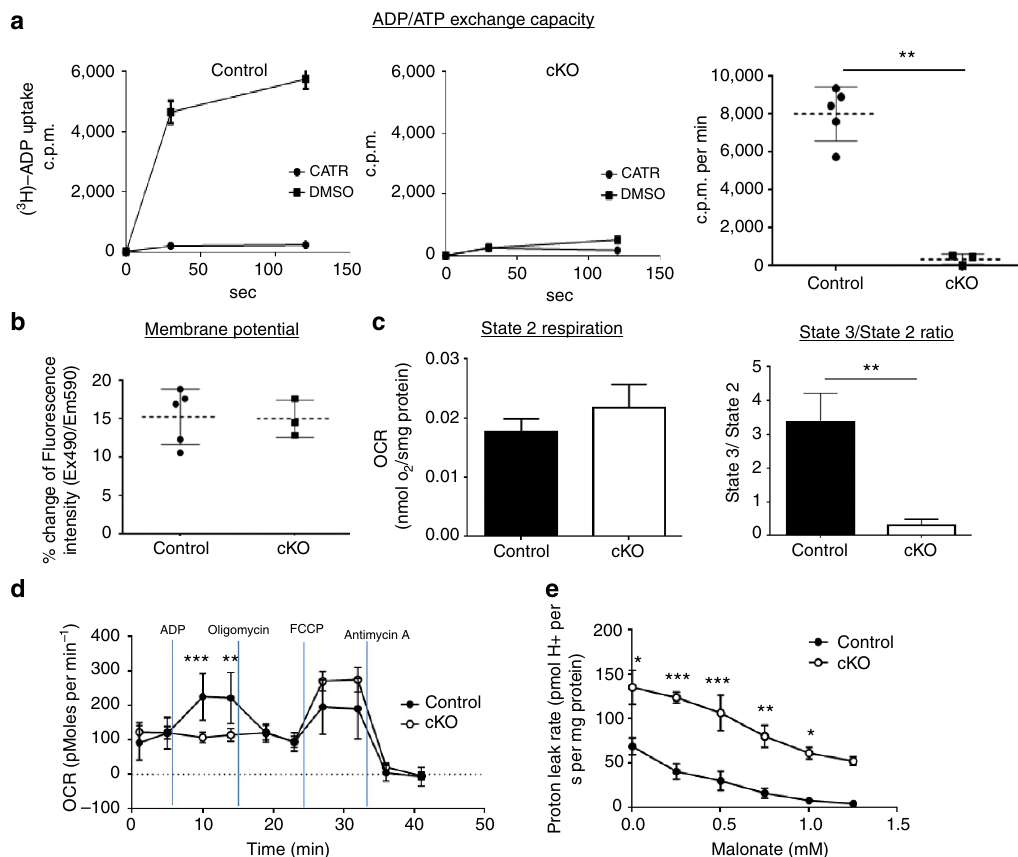
Figure 3 | Characterization of Ant2 -deleted liver mitochondria. ( a ) ADP/ATP exchange capacity measured by [ 3 H]ADP uptake in the presence or absence of the ANTspecific inhibitor, carboxyatractyloside (CATR). Left two panels show representative data from control and Ant2 cKO liver mitochondria, while the far right graph shows the average of multiple experiments ( n ¼ 5; ** P o 0.01 by t -test, error bars ¼ s.d.). ( b ) Membrane potential assessed by JC1 dye. ( c ) Mitochondrial oxygen consumption rate (OCR) measured using a Hansatech Oxygraph unit. The state 2 respiration represents the basal respiration rate under glutamate while the state 3 respiration rate was measured after the addition of ADP ( n ¼ 5; ** P o 0.01 by t -test, error bars ¼ s.d.). ( d ) Mitochondrial OCR assessed with XF24 extracellular flux analyzer (Seahorse) under sequential treatment of ADP, oligomycin, FCCP, and Antimycin A ( n ¼ 5; ** P o 0.01, *** P o 0.001 by t -test, error bars ¼ s.d.). ( e ) Proton leak rate of isolated liver mitochondria was assessed with Oroboros O2k respirometer in the presence of succinate, rotenone, oligomycin and increasing concentrations of malonate ( n ¼ 5, * P o 0.05, ** P o 0.01, *** P o 0.001 by t -test, error bars ¼